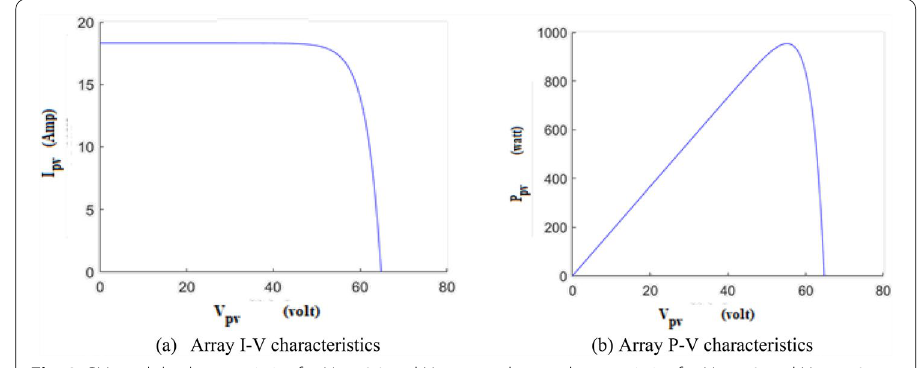
36 and Np 1 and array characteristics for Nss = =